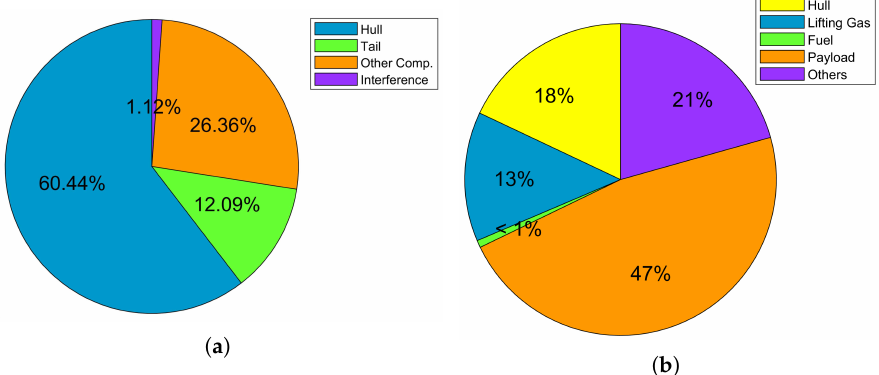
Figure 10. ( a ) Drag and ( b ) mass distributions of the baseline model of tri-lobed